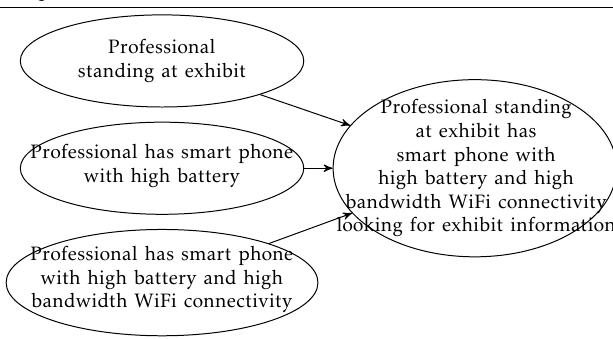
Figure 3. ECR from Two’s Combination of Context Information